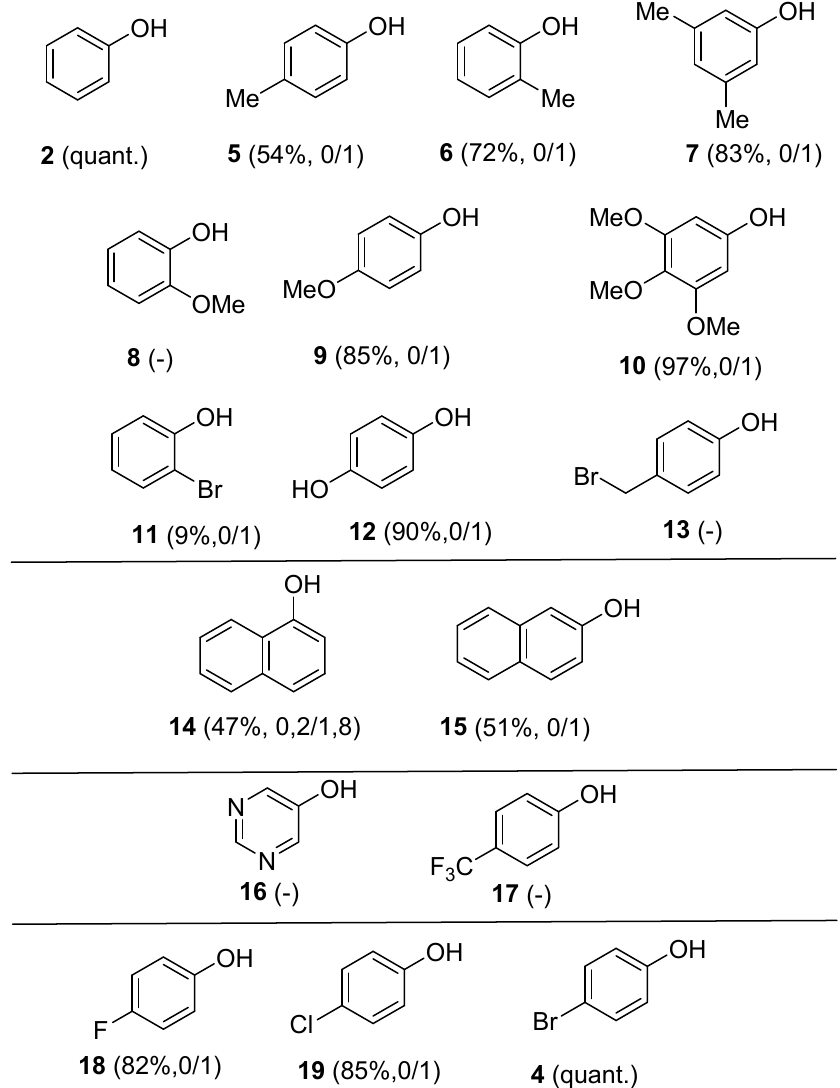
Figure 6. Substrate scope (isolated yields, ratio starting